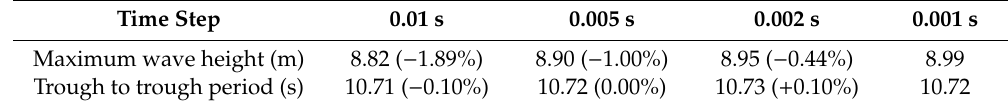
Table 4. Time step sensitivity study (medium mesh).